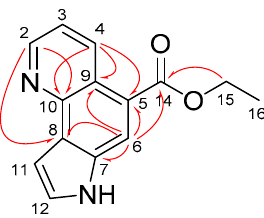
Figure 3. Selected HMBC correlations (H → C) of synthesized 1 .